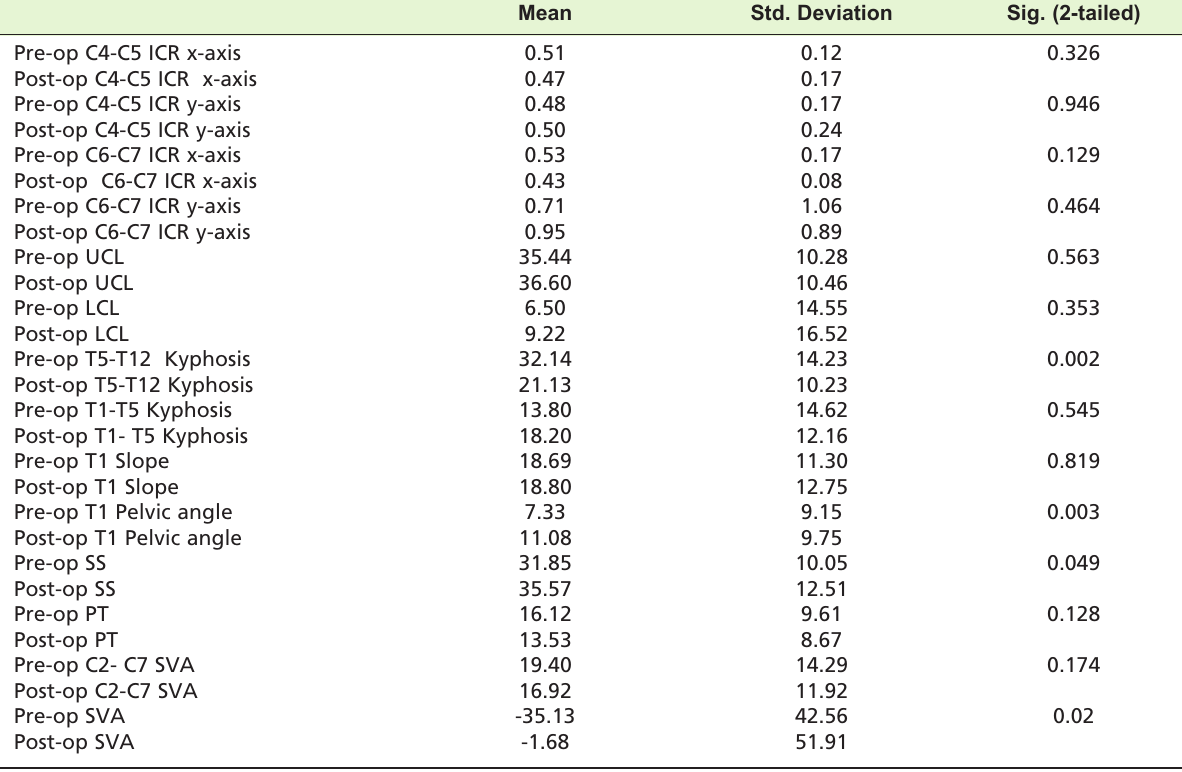
Table I: Pre-operative – post-operative comparison of ICR location and sagittal plane parameters Mean Std. Deviation